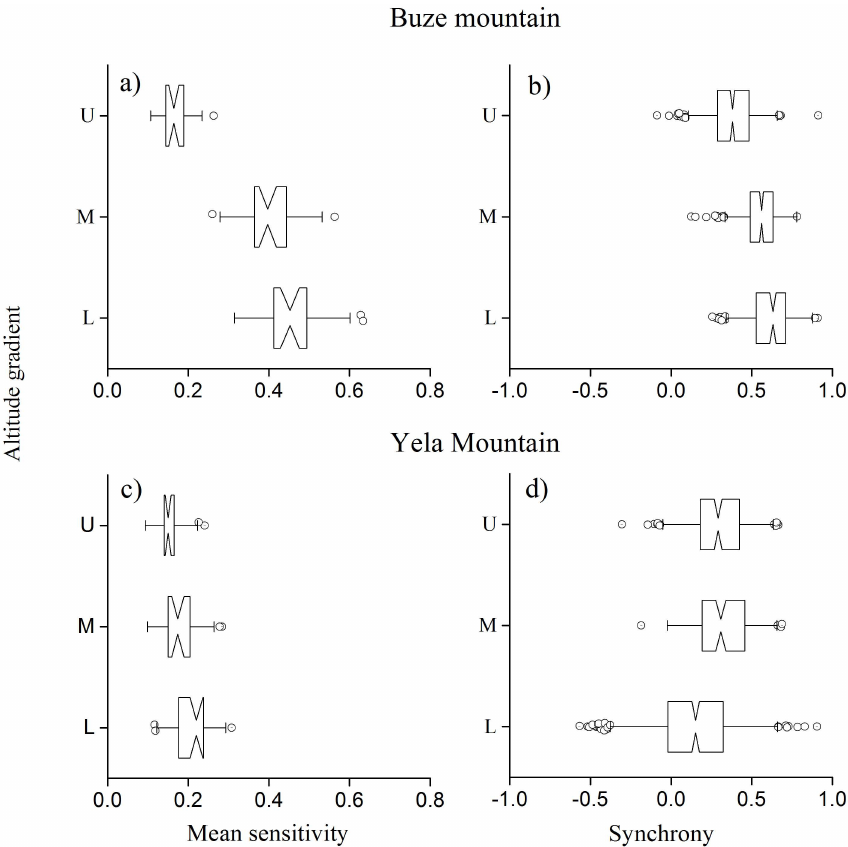
Fig 5. Mean sensitivity and growth synchrony among individual tree-ring sequences at three altitudes in Buze and Yela Mountains. L, M, and U represent lower, middle and upper